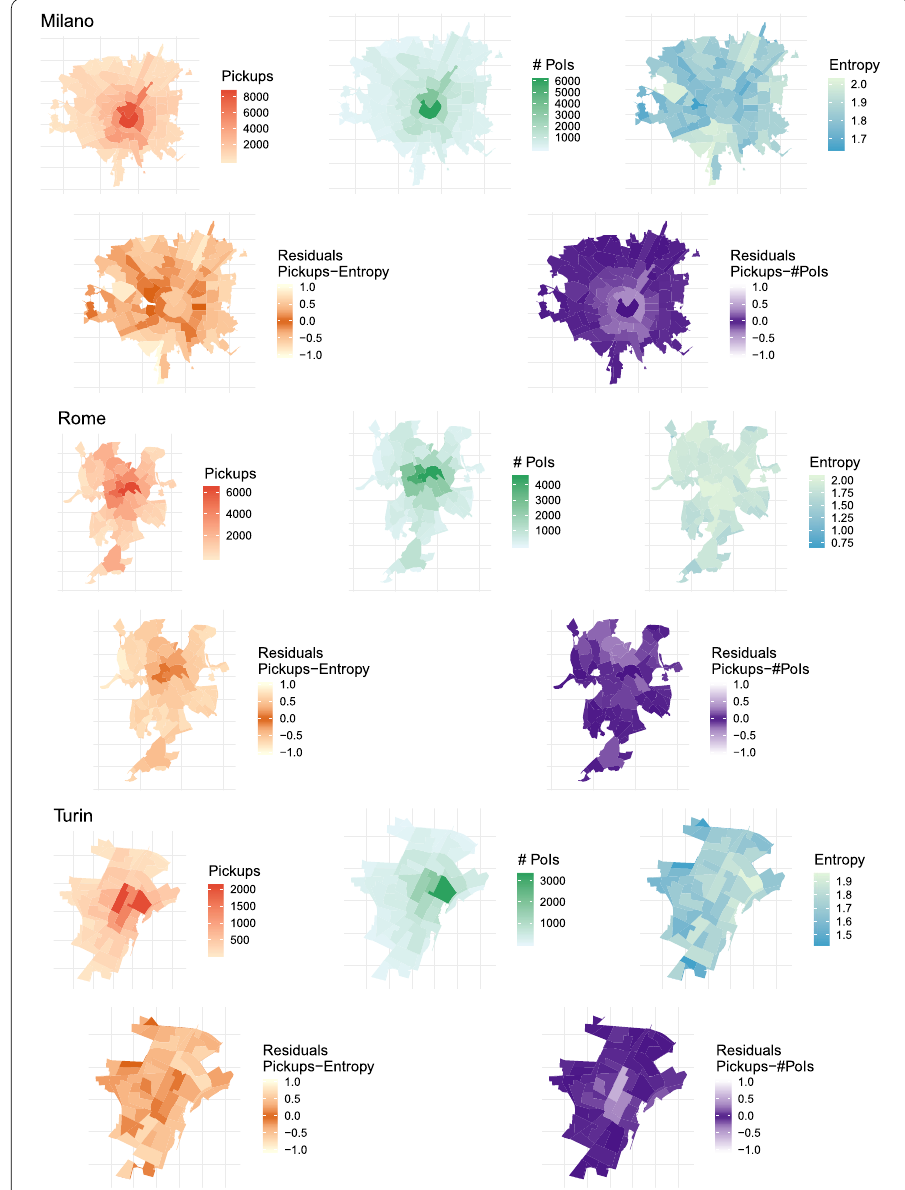
Figure 3 Map of number of pickups, number of PoIs, entropy, residuals of rescaled pickups and entropy, residuals of rescaled pickups and PoIs in Milan, Rome, Turin. The residuals are computed after rescaling the variables in range [0,1], then subtracting. Intuitively, they correspond to the deviation from perfect